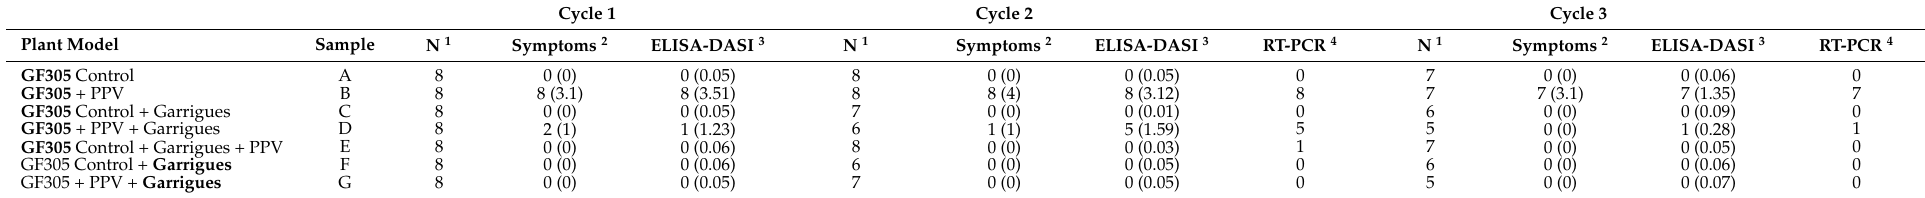
Table 1. Evaluation of behaviour against PPV in the assayed plant material. The samples assayed included control healthy “GF305” peach rootstocks (A); PPV-infected “GF305” rootstocks showing severe sharka symptoms (B); “GF305” peach rootstocks grafted with healthy “Garrigues” (C); PPV-infected “GF305” rootstocks showing sharka symptoms grafted with healthy “Garrigues” (D); healthy “GF305” peach rootstock grafted with healthy “Garrigues” which were later inoculated with PPV at the end of the first cycle of evaluation (E). In addition, “Garrigues” almond samples grafted onto healthy (F) and inoculated “GF305” (G) rootstocks were included in the study. Bold type refers to the evaluated plant material GF305 peach and Garrigues